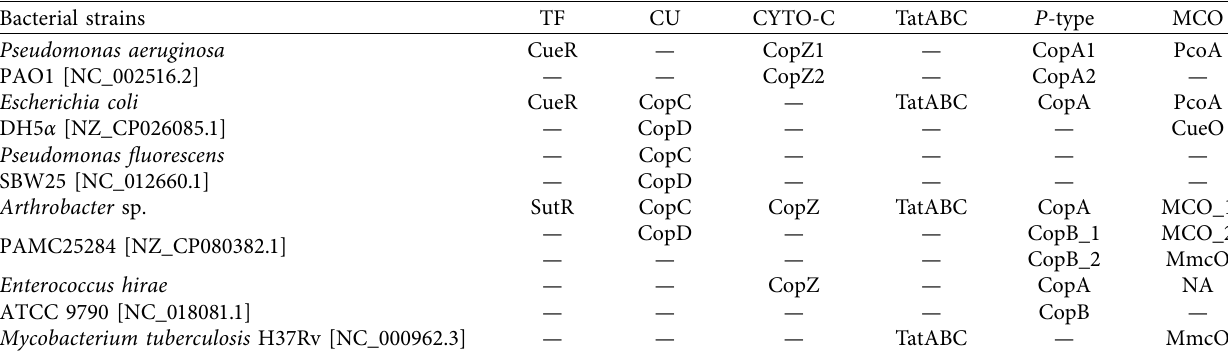
Table 2: List of cuproproteins and copper transporters, chaperones, and multi-copper oxidases examined in this study of different reference strains with their accession number indicated in parentheses. TF, transcription factor; CU, copper uptake; CYTO-C, cytoplasmic copper chaperone; TatABC, twin-arginine translocation system; P -type, P -type copper ATPase; MCO, multi-copper oxidase; and —, not applicable.